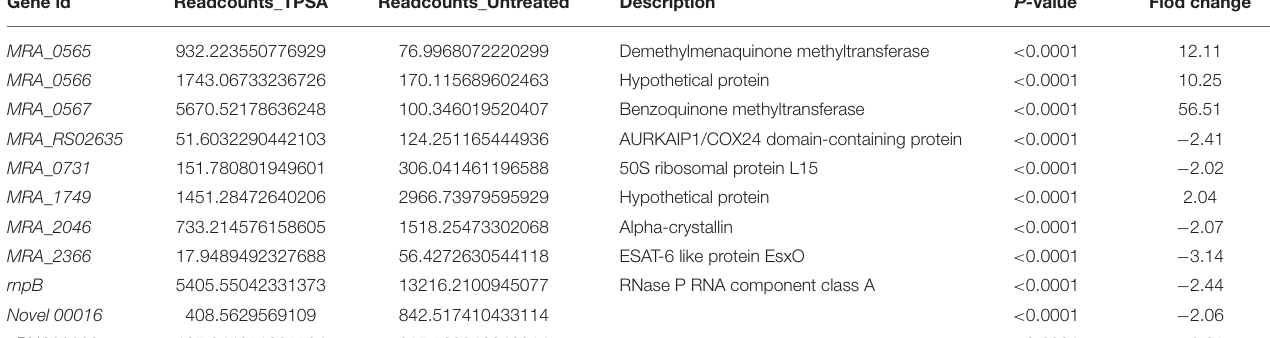
TABLE 4 | List of differentially expressed genes identified in TPSA-treated H37Ra using RNA-Seq. Gene id